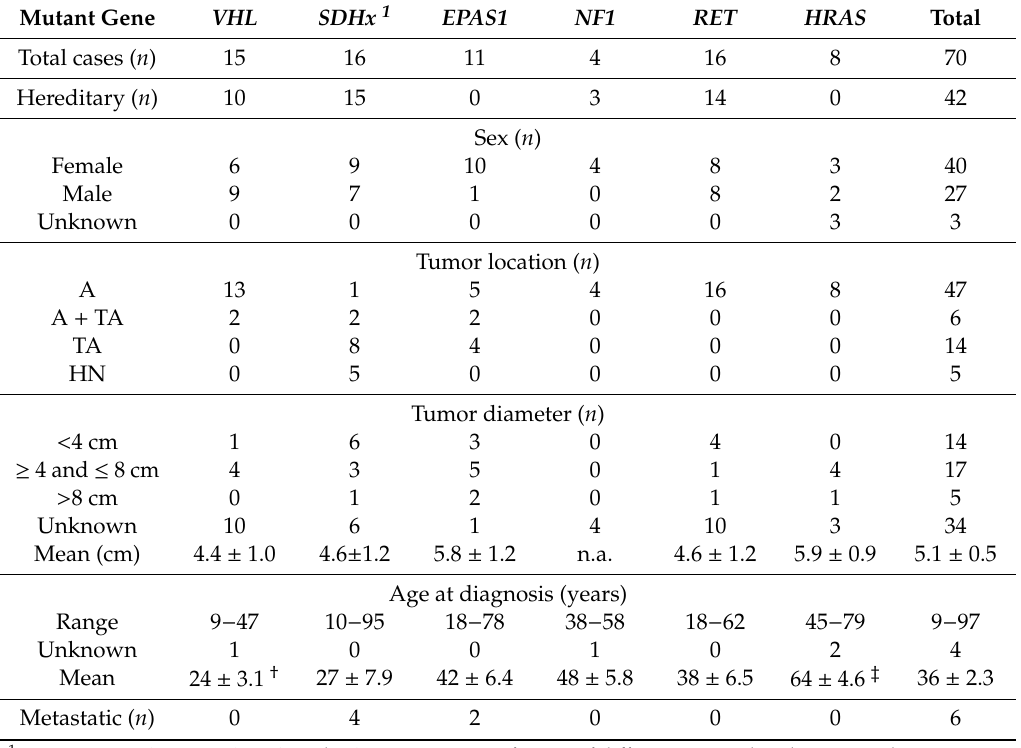
Table 1. Tumor characteristics and clinical features of 70 PPGL patients extracted from [50,51] for COX-2 gene expression analysis; (A) adrenal; (TA) thoracic and abdominal; (HN) head and neck. Mutant Gene VHL SDHx 1